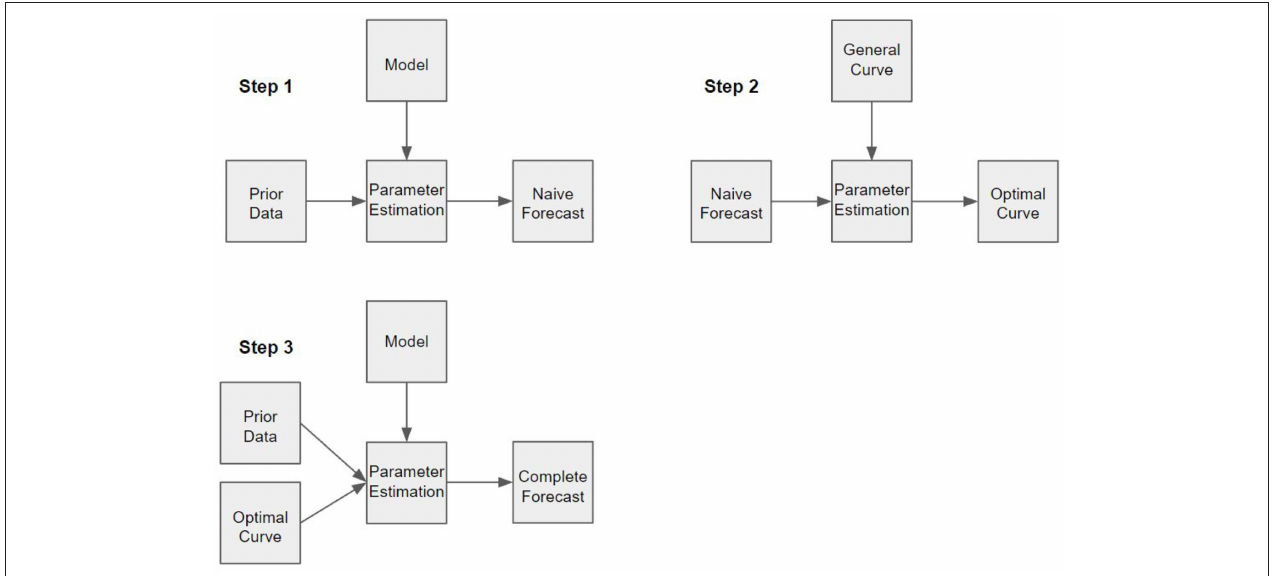
FIGURE 1 | Schematic of the three step data assimilation procedure. In each step, some model is being optimized with respect to provided information. In step one, the physical model is being optimized with respect to prior data to produce a naive forecast. In step two, a family of possible field-line curves is optimized with respect to the naive forecast to produce an optimal field-line curve, which is the best approximation of the field-line. In step three, both the prior data and the optimal curve are used to optimize the physical model and produce a complete